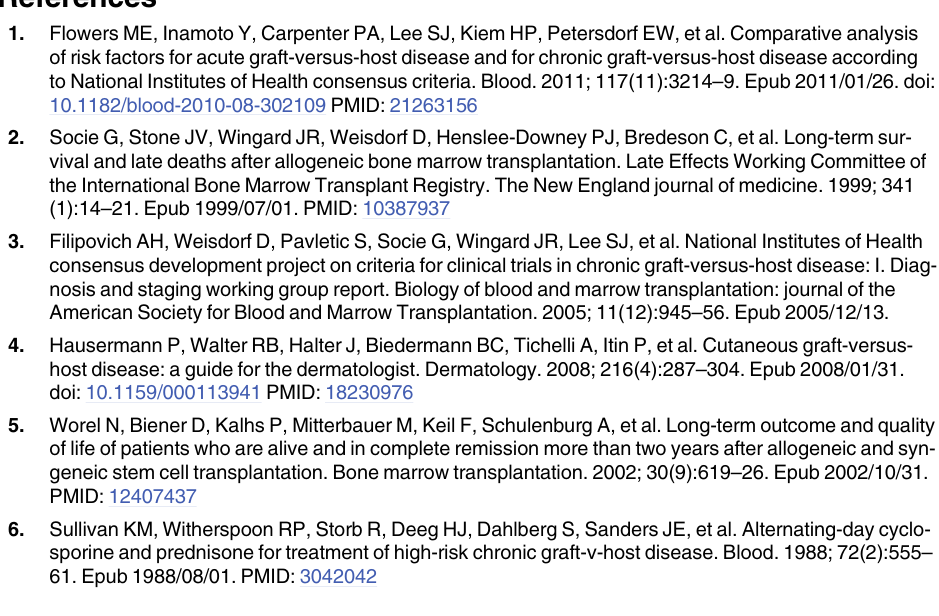
S1 Fig. Comparative analysis of apoptosis in leukocytes after ECP. Leukocytes from cGVHD patients taken from buffy coat before and after chemoirradiation were stained for Annexin-/ 7-AAD- double negative cells immediately after ECP and after 24h. (cid:1) p (cid:3) 0.05, (cid:1)(cid:1) p (cid:3) 0.01 (TIF) S2 Fig. Suppression of lymphocytes by neutrophils ex vivo after ECP. Neutrophils isolated from 3 patients with chronic GVHD were added to autologous (upper row) or heterologous (lower row) monocyte-depleted mononuclear cell fractions in different ratios after labelling of mononuclear cells with cell proliferation dye efluor 450. T-cells were stimulated with plate- bound antibodies against CD3 and CD28. Proliferation was measured via flow cytometry after 5 days of proliferation and gating on the lymphocyte fraction. (A) representative data of one donor showing proliferation of lymphocytes. (B) Mean of suppression of 3 donors ± standard deviation. (TIF) S1 Table. List of antibodies used for flow cytometric analysis of activation markers.